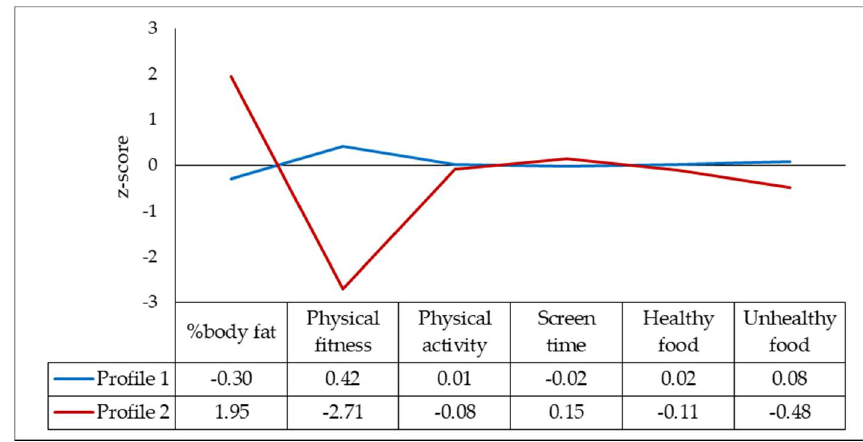
Figure 1. Profiles’ display for biological health markers, as well as lifestyle behaviors. Table 2. Criteria used to identify the best number of latent profiles. Number of Fit Measures